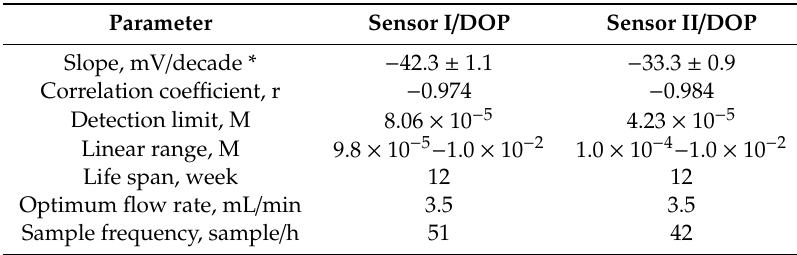
Figure 4. Signals obtained in triplicate for ( A ) sensor I and ( B ) sensor II. Conditions: carrier solution, Table 2. Performance characteristics of 2,6-DCPIP membrane sensors under hydrodynamic mode of operation in 30 mM Tris bu ff er (pH